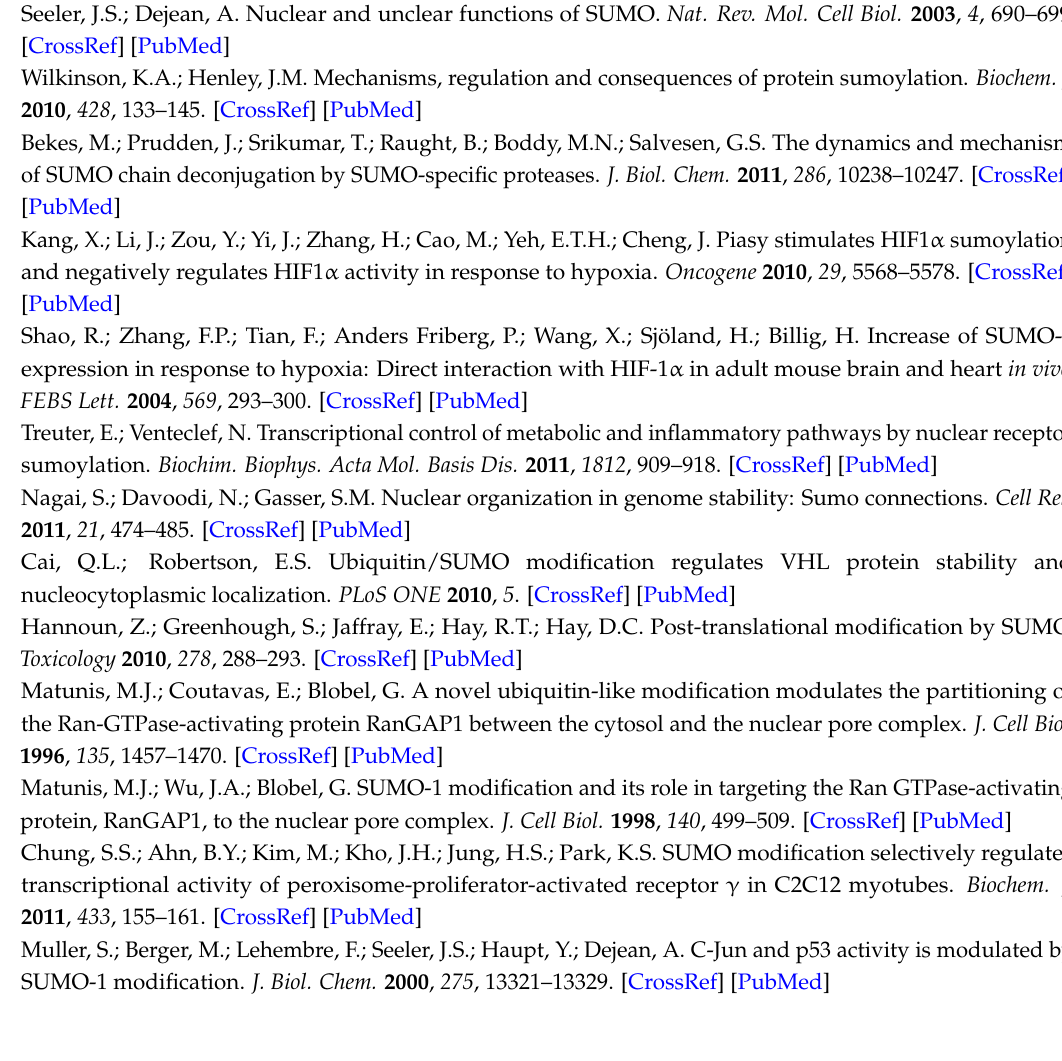
Figure 2. Immunohistochemical and immunofluorescence staining of SUMO-1 in skeletal